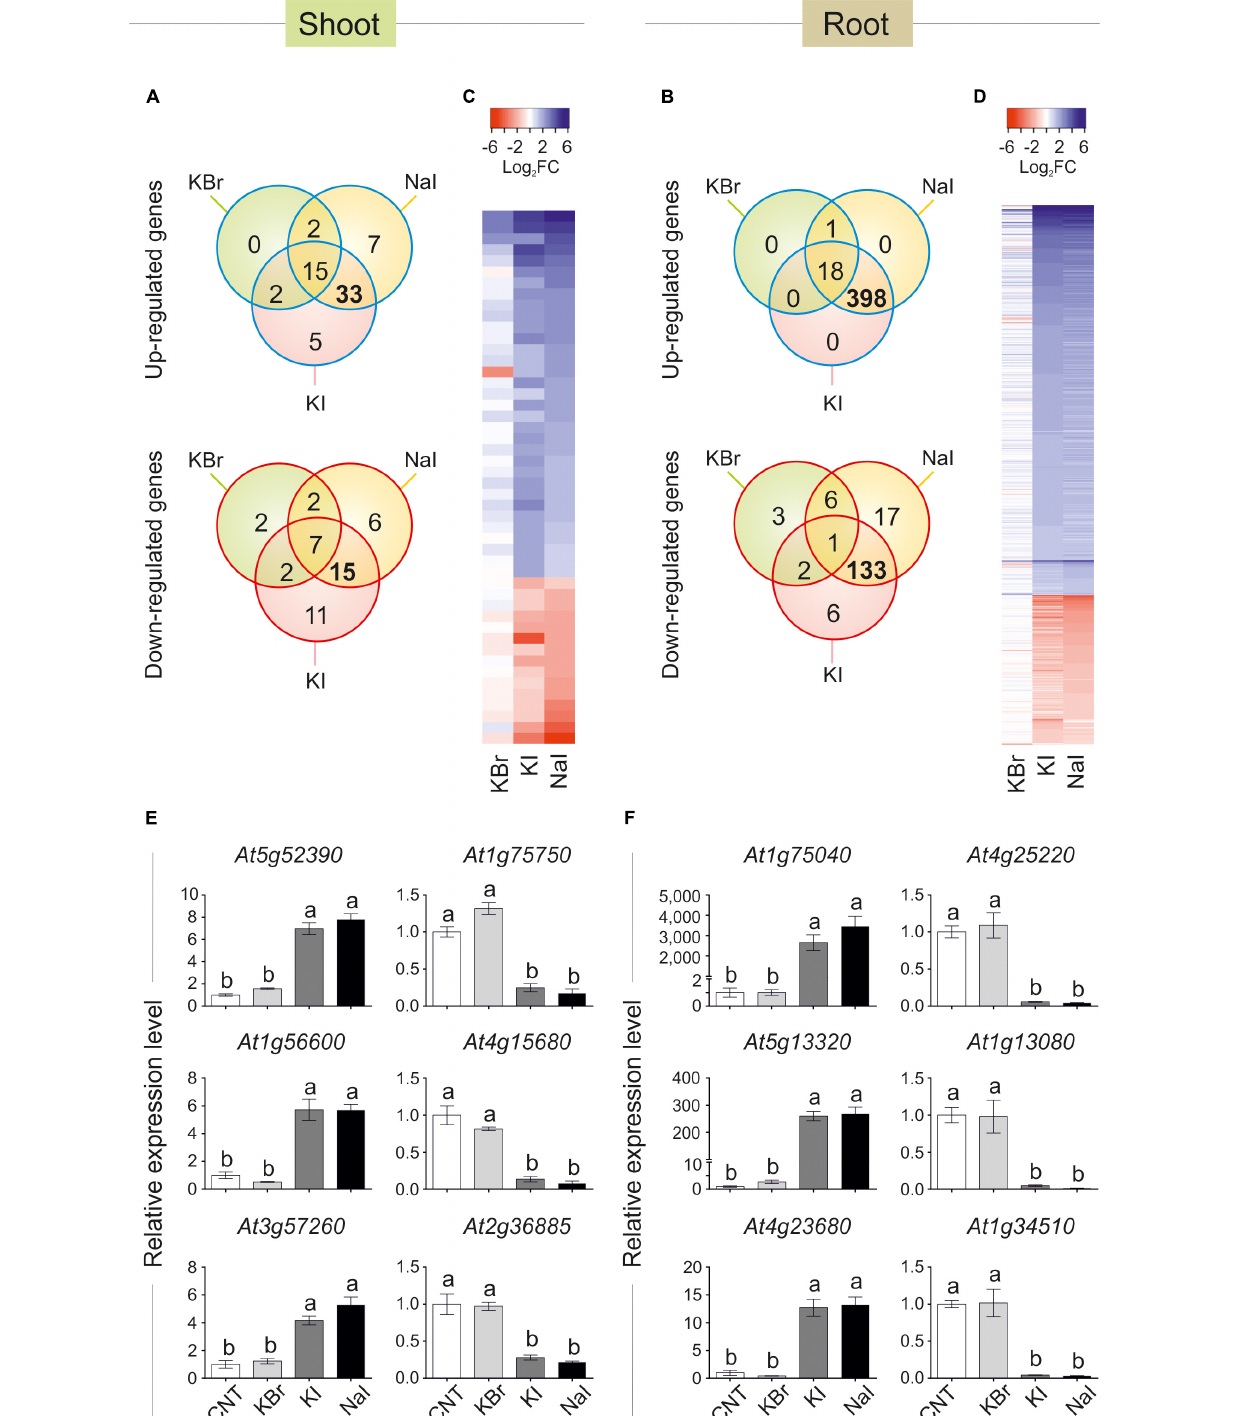
Frontiers in Plant Science |